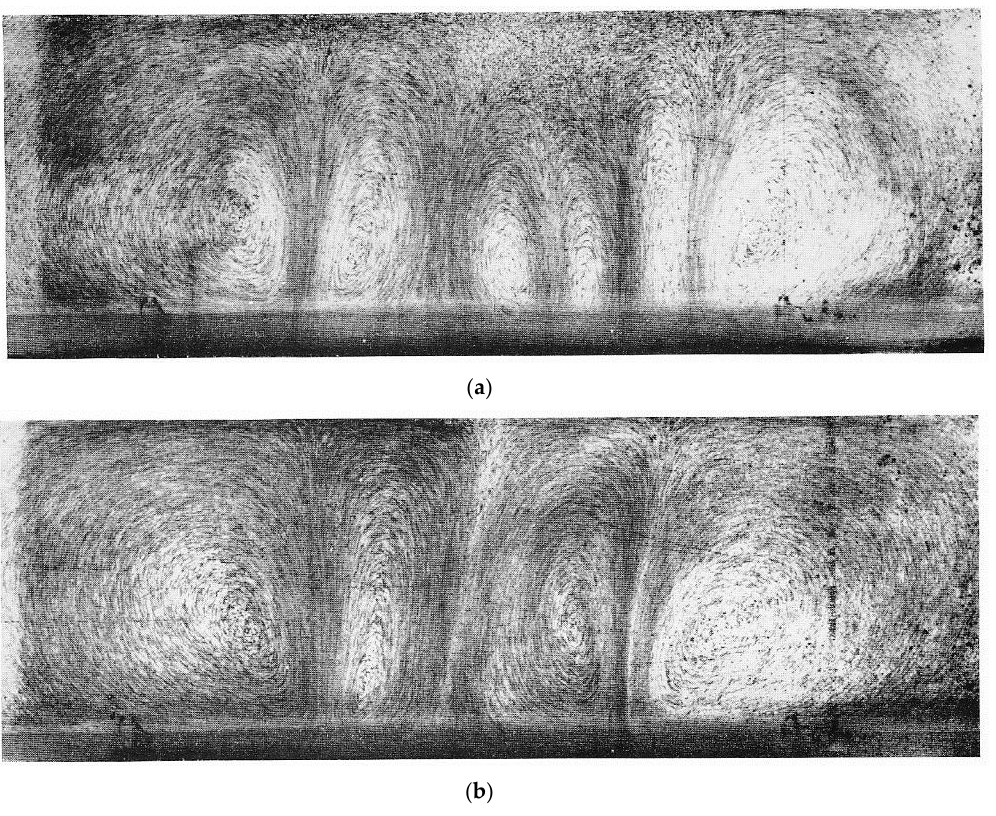
Figure 3. Visualization of the streamlines of a flow in a Hele-Shaw cell. [Figure 5, Plate 2 (after Plate 1, facing page 624) Journal of Fluid Mechanics 1967, 27, 609–623 [2]. Copyright Permission from Elder, J.W., Transient convection in a porous medium; published by Cambridge University Press, 1967.] Table 1. Plume development stages in the numerical model of the Hele-Shaw cell ( Journal of Fluid Mechanics 1967, 27, 609–623) [2].